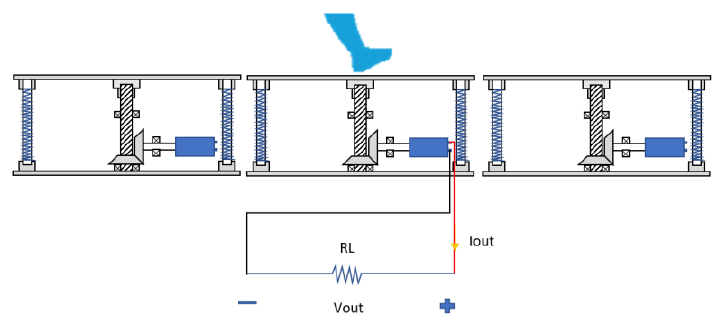
Figure 15. Test Set up Diagram for the Prototypes.